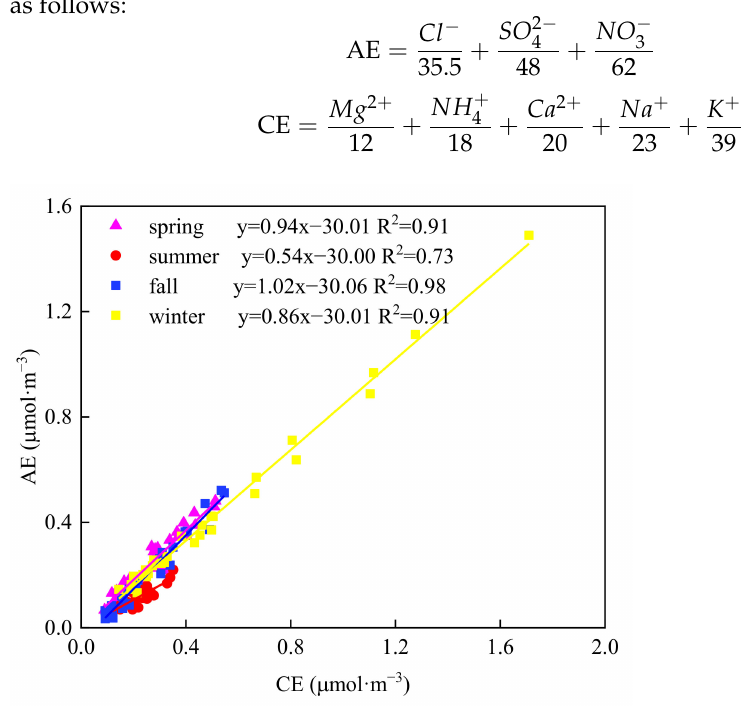
Figure 3. Plot of cations concentration vs. anions concentration in four